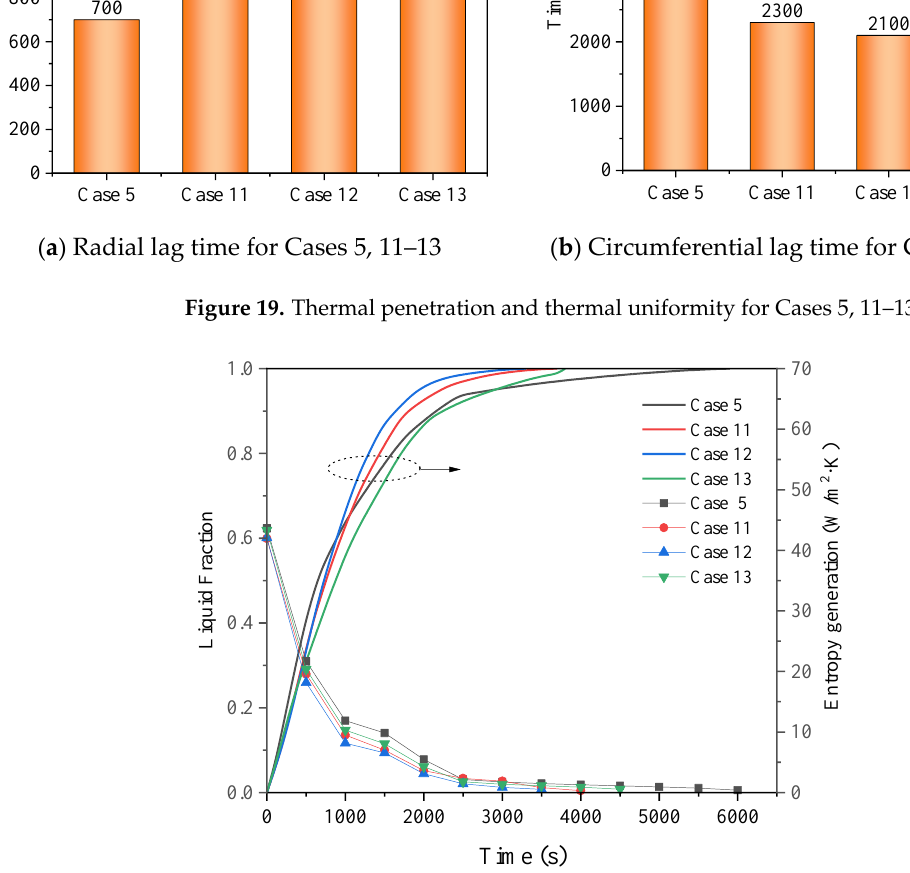
Figure 20. Liquid fractions and entropy generation for Cases 5, 11 – 13.